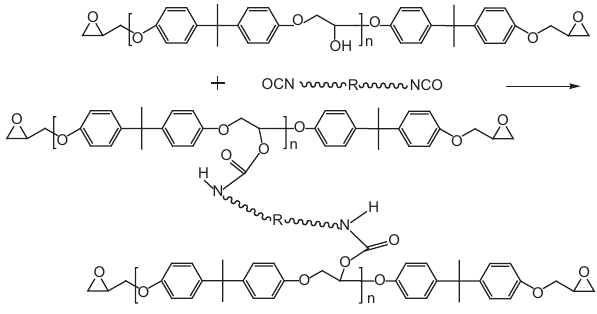
Scheme 2 Chemical reaction between DGEBA and pre-polymer.